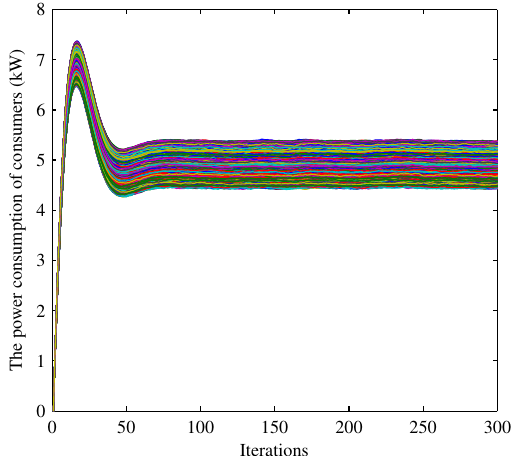
Figure 6. Convergence of 1000 consumers’ power